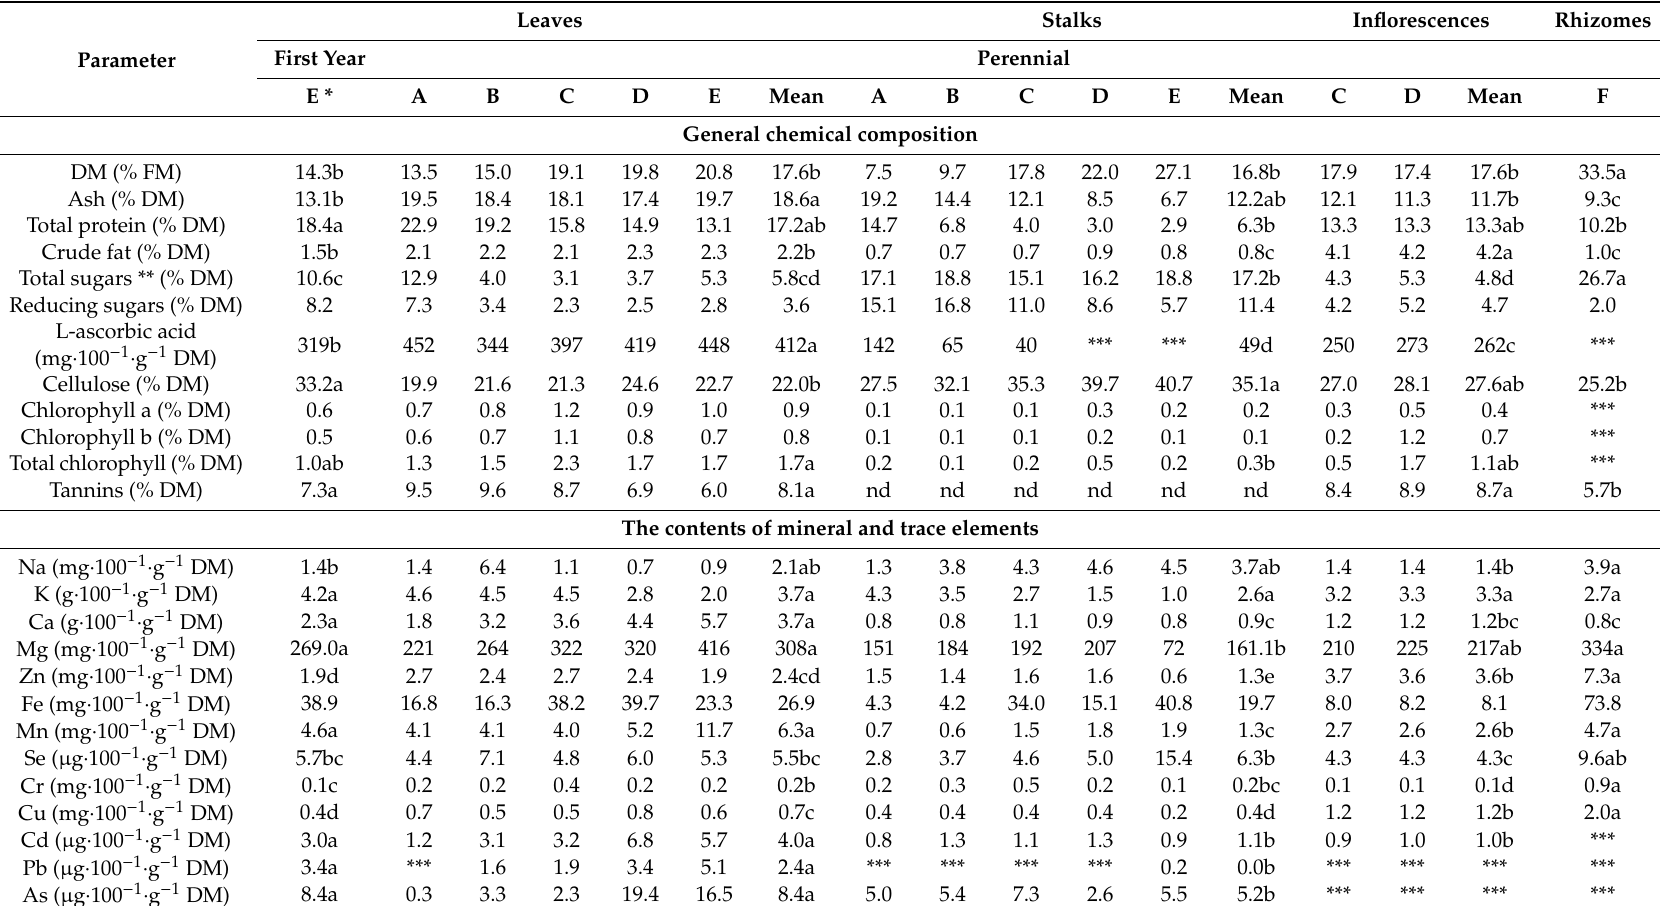
Table 3. Chemical composition of Silphium perfoliatum